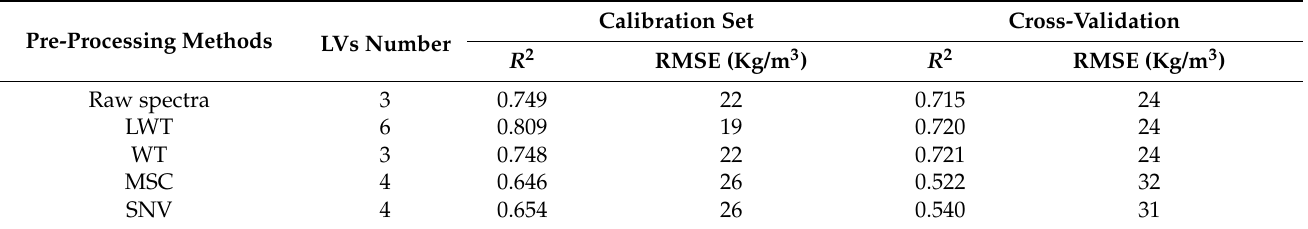
Table 1. PLS model’s results with different pre-processing for the prediction of Chinese white poplar wood density.